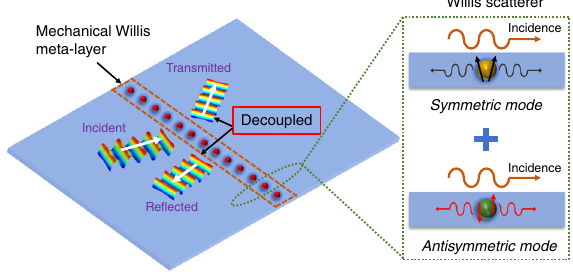
Fig. 1 Schematic of the mechanical Willis meta-layer embedded with an array of active Willis scatterers. The re fl ected and transmitted fi elds can be independently controlled by the active Willis scatterers. The active Willis scatter with asymmetric polarizabilities can operate symmetric and antisymmetric